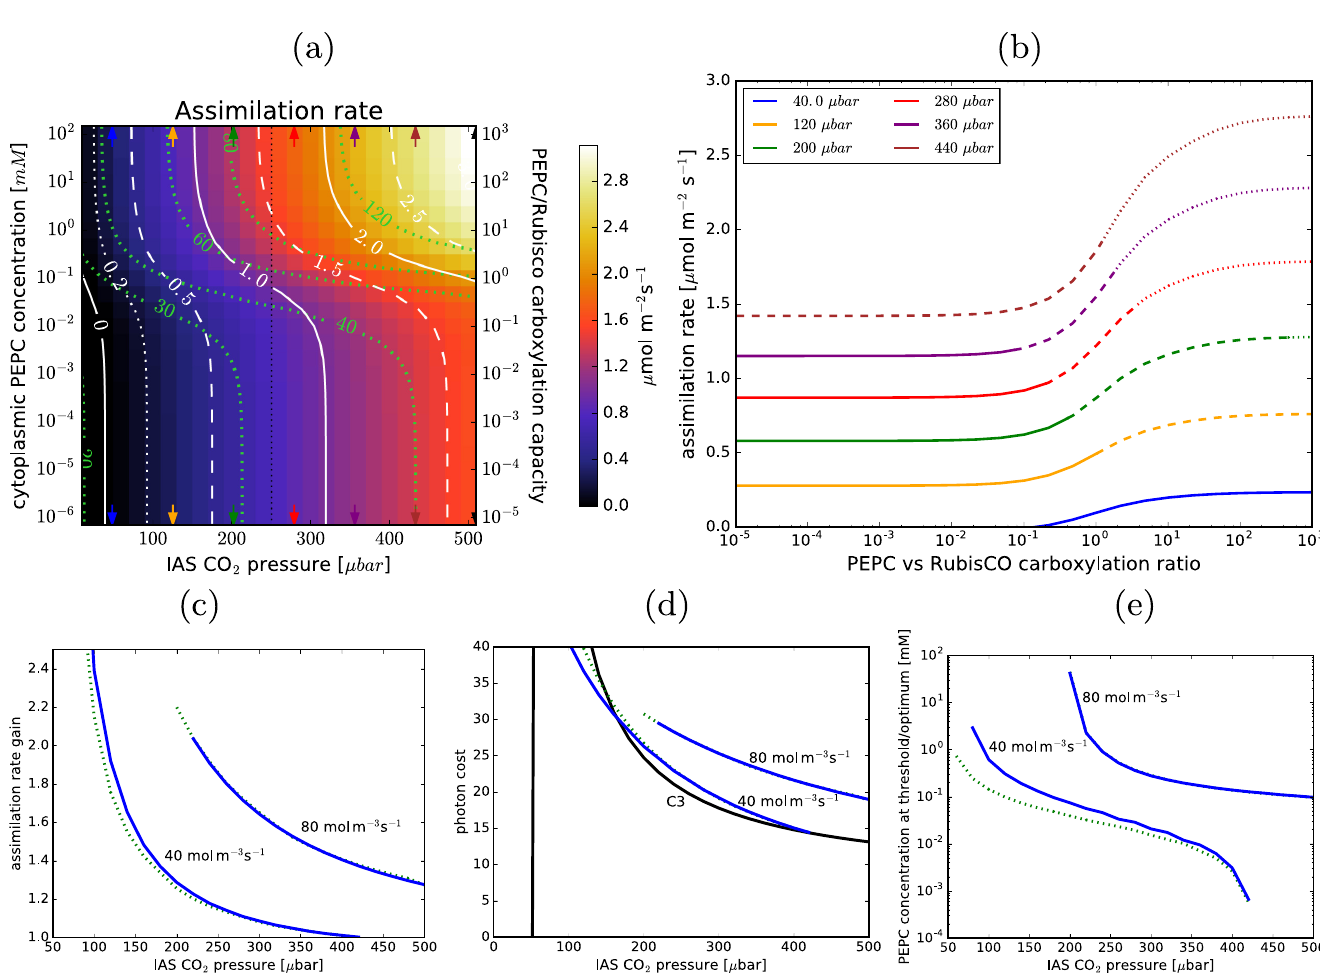
Fig 7. C 4 photosynthesis at limited CO 2 in the IAS. (a): The net assimilation rate as a function of the IAS CO 2 pressure and PEPC concentration in the cytoplasm, for the default parameter choice (Table 1; specifically, the envelope permeability is 600 μ m/s). No light utilisation cap is imposed, but the utilisation thresholds are marked in green. The vertical dotted line marks the CO 2 pressure used as default in other figures. (b): Assimilation rate vs PEPC-to-Rubisco carboxylation capacity ratio for several CO 2 pressures (marked with arrows in a). (c): The relative gain in the assimilation rate (compared to C 3 photosynthesis) at the PEPC activity levels where the light usage reaches 40 mol m -3 s -1 and 80 mol m -3 s -1 (dotted green lines) and the maximal assimilation gains when the corresponding light limits are imposed (blue lines). (d): the photon costs corresponding to assimilation gains in (c); the black line marks the cost of C 3 photosynthesis (below 50 μ bar C 3 photosynthesis cannot reach the compensation point), the blue and green lines as in (c). (e): the respective PEPC concentrations at which the optimal gains are achieved in (c) and (d).